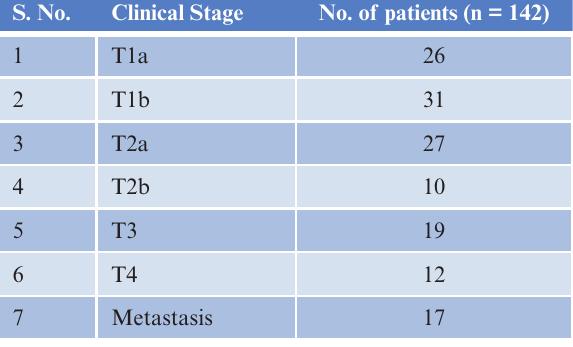
Table 3: Stage at presentation. S. No.